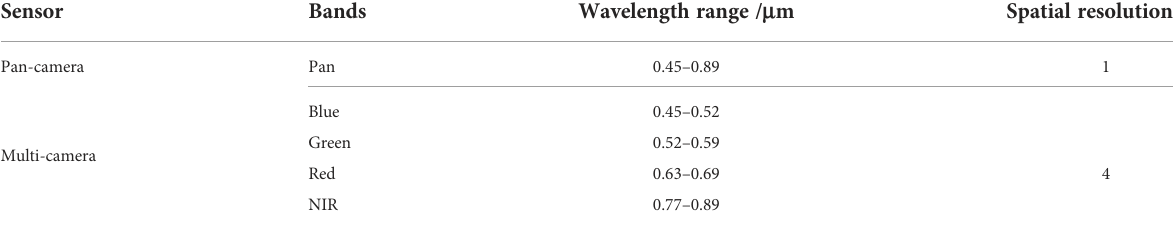
TABLE 2 The details of the Chinese GF-2 sensor parameters used in the current